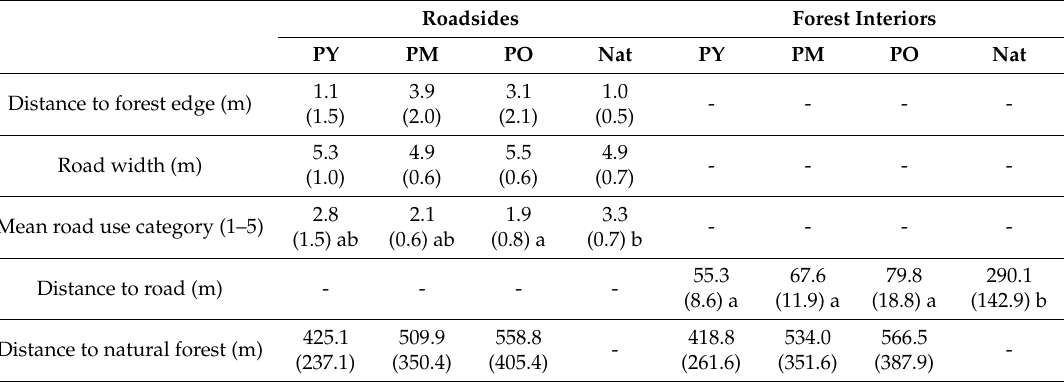
Table A1. Landscape variables of roadside and forest interior transects. For roadsides the distance to the forest edge and the road width were determined (measured from the transect center). Roads were assigned to different use categories based on a subjective evaluation of the frequency of vehicle traffic from 1 (main road) to 5 (no traffic during observation period). For forest interior transects, the distance to the nearest road was determined (minimum distance was 50 m). For both habitat types the minimum distance to natural forest remnants based on aerial photographs was determined. Given are mean values per transects with standard deviation in parenthesis. Different lower case letters indicate significant differences among forest types.